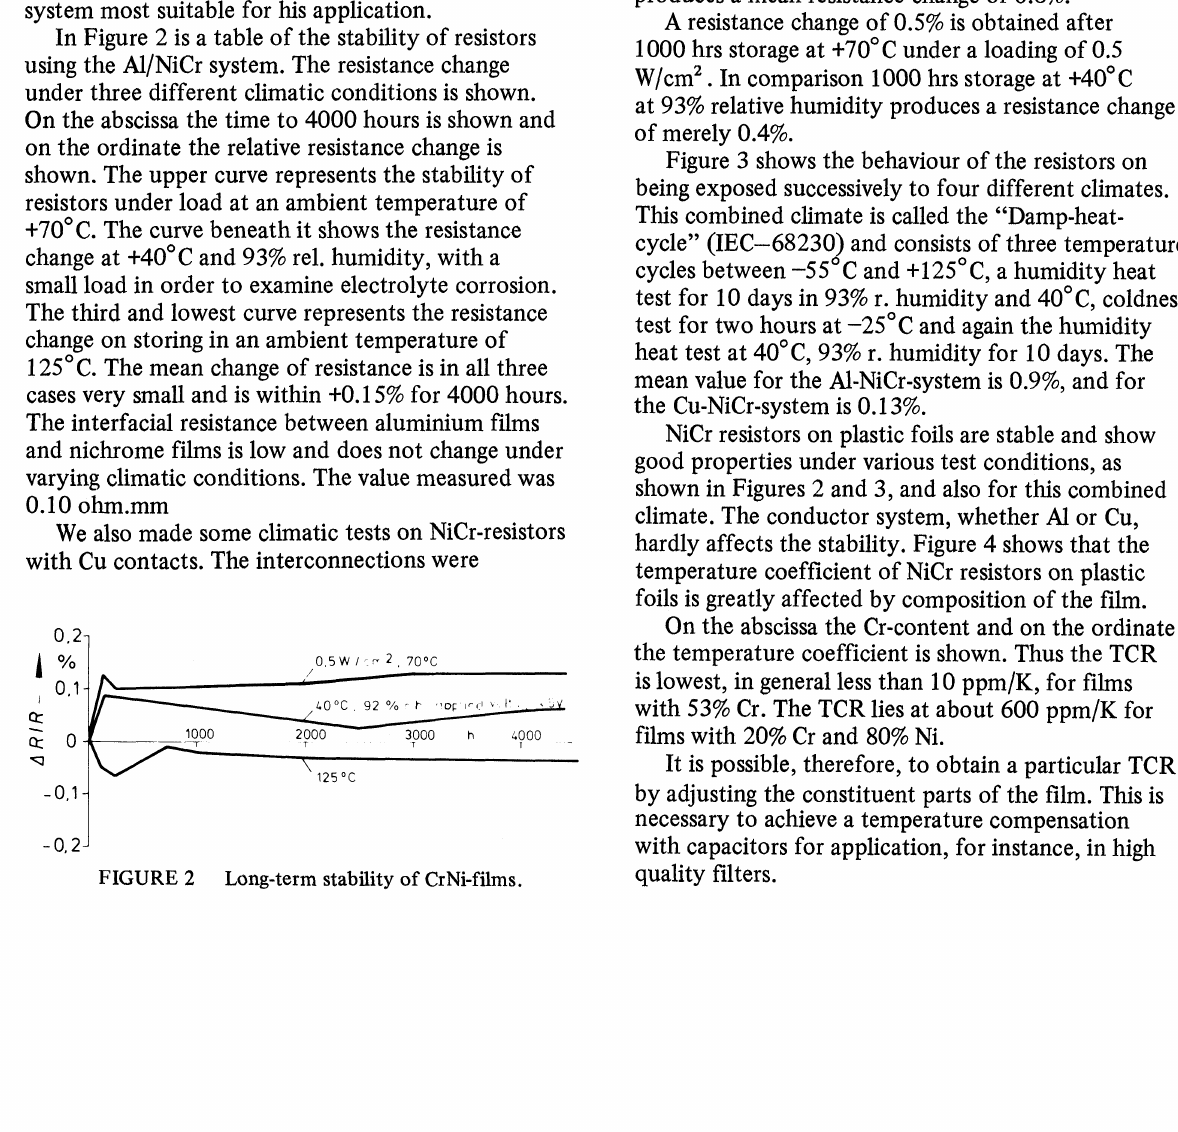
Resistors on plastic foil in damp-heat